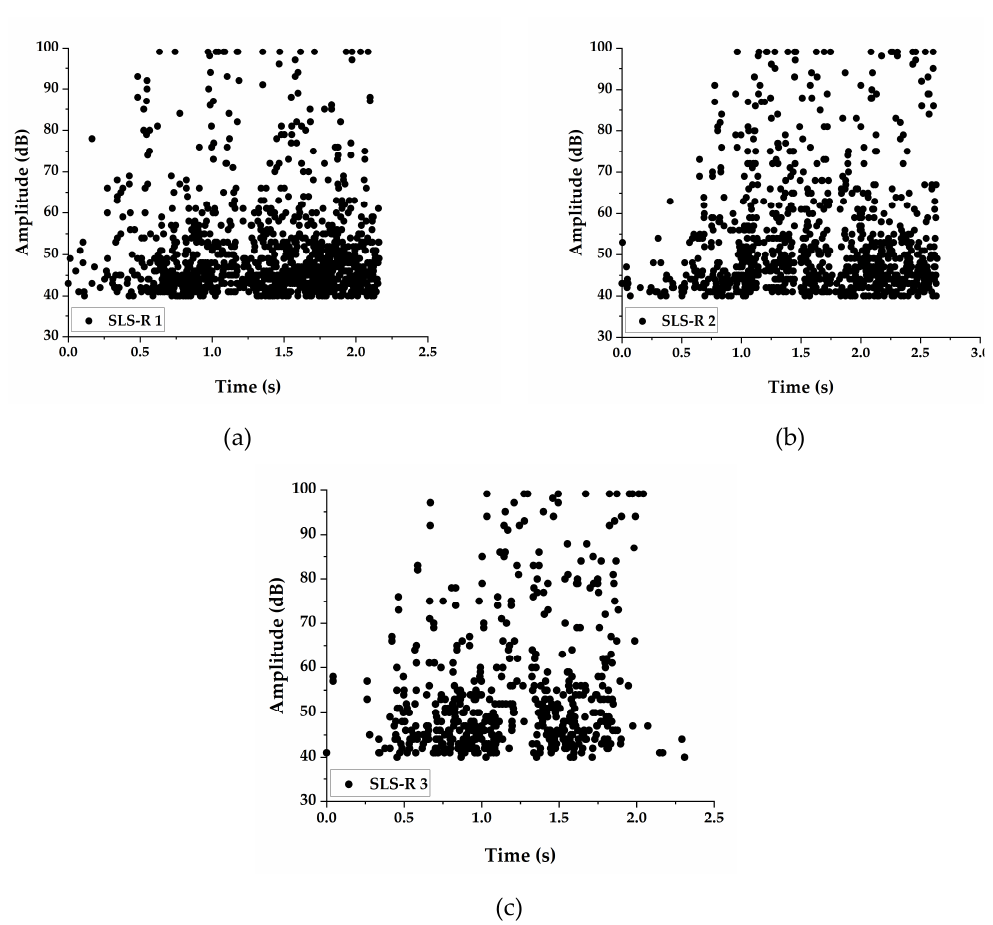
Figure 8. Peak Amplitude distribution for Specimens ( a ) SLS-R 1 ( b ) SLS-R 2 and ( c ) SLS-R 3.